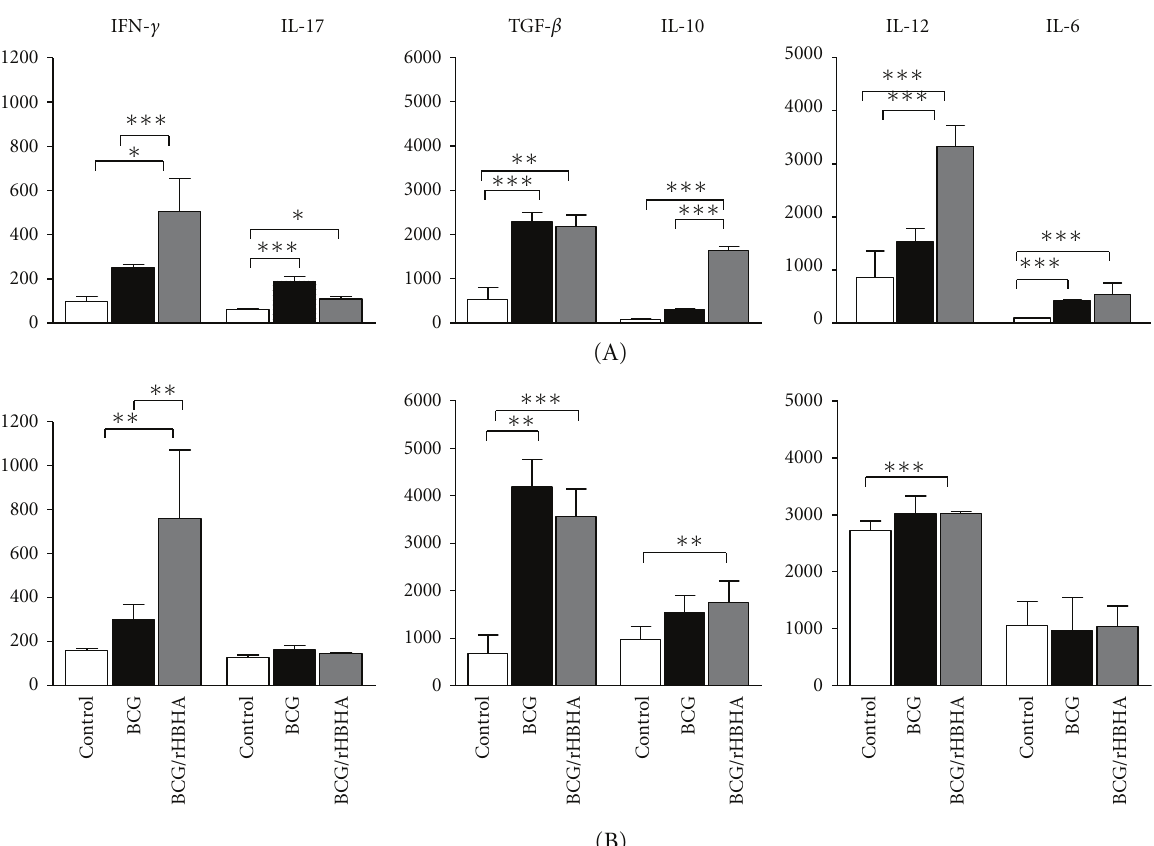
Figure 1: Spleen cell cytokine profile of BCG-vaccinated mice with or without rHBHA boost after M. tuberculosis infection. Eight weeks after i.n. (A) or aerosol (B) challenge spleen cells from control mice (white bars), BCG-vaccinated mice (black bars), or BCG-vaccinated/rHBHA- boosted mice (gray bars) were cultured in the presence of medium only, ConA (2.5 μ g/mL), or rHBHA (5 μ g/mL). Levels of cytokines were measured after 72h culture in the supernatants by using the OptEIA kit (BD Biosciences). Values are expressed in pg/mL and represent media ± SEM of samples tested in duplicates from each group of mice. The data was considered statistically significant when P < 0 . 05 ( ∗ ), P < 0 . 001 ( ∗∗ ), and P < 0 . 0001 ( ∗∗∗